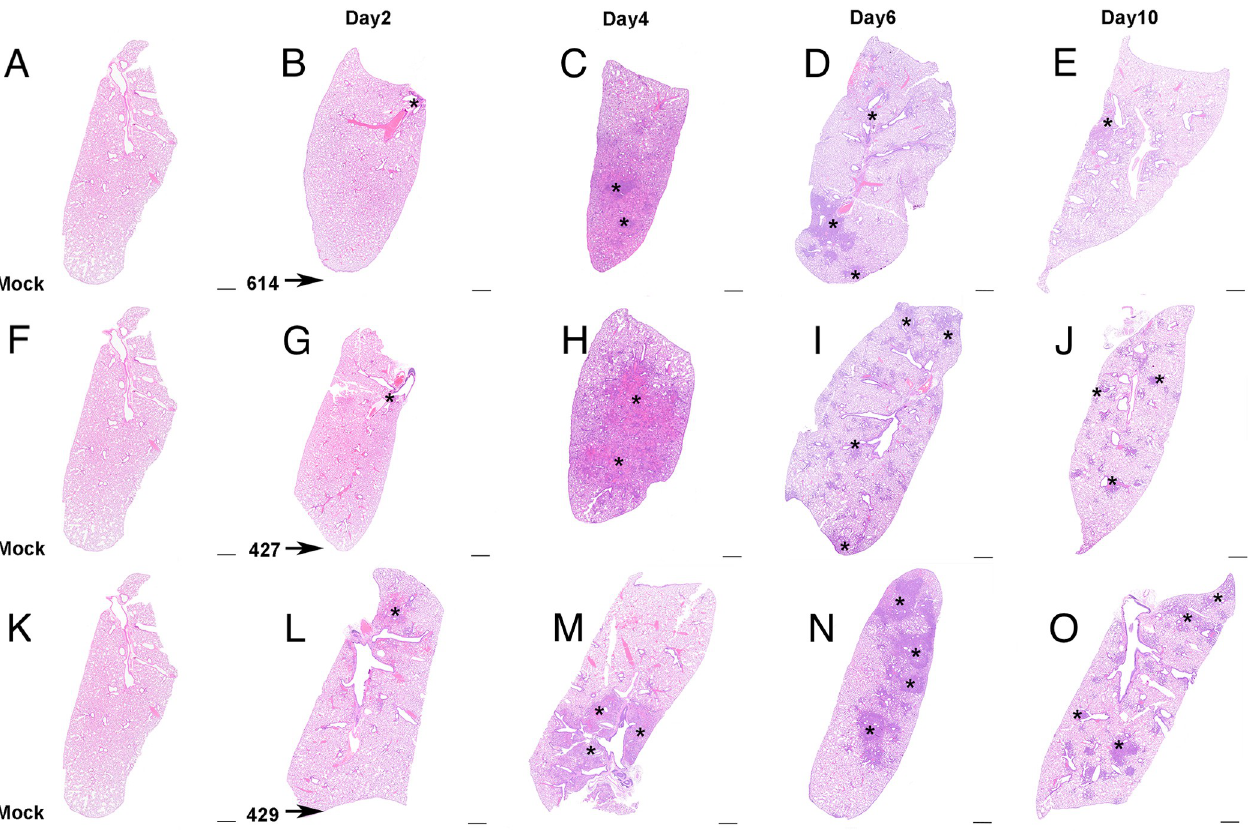
Fig 2. Lung histopathology in hamsters after intranasal inoculation with B.1.429 is more acute and prolonged than in hamsters inoculated with B.1 (614G) and B.1.427. A, F, K) Sub-gross histology of normal lungs from uninfected hamsters. Top row: Sub-gross histology of B.1 (614G) infection after B) 2 days PI, C) 4 days PI, D) 6 days PI, E) 10 days PI. Middle row: Sub-gross histology of B.1.427 infection after G) 2 days PI, H) 4 days PI, I) 6 days PI, J) 10 days PI. Bottom row: Sub-gross histology of B.1.429 infection after L) 2 days PI, M) 4 days PI, N) 6 days PI, O) 10 days PI. Asterisks = foci of inflammation, necrosis and/or hemorrhage. Hematoxylin and eosin stain. Original magnification: 1x. Scale bars equal 1 mm.